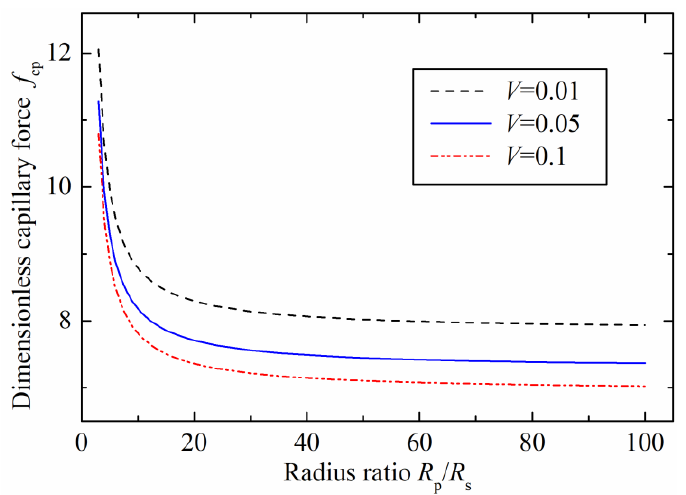
Figure 5. Effects of the radius ratio on the dimensionless capillary force.